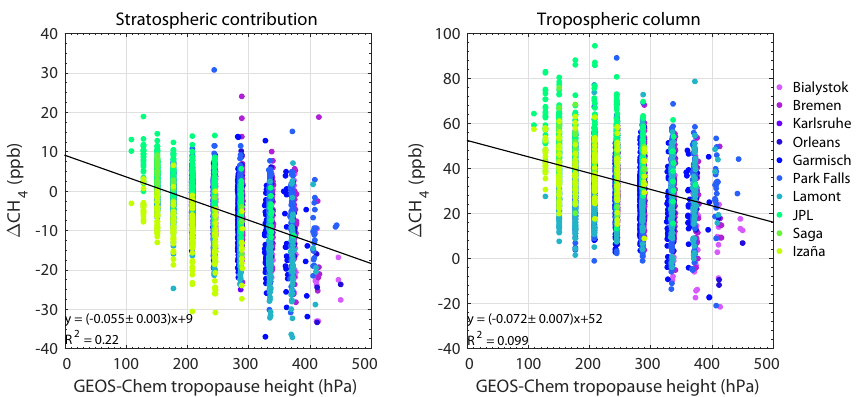
Figure 6. TCCON minus GEOS-Chem CH 4 column-averaged DMFs as a function of the effective GEOS-Chem tropopause height, shown for Northern Hemisphere sites. Site colors are as in Fig.